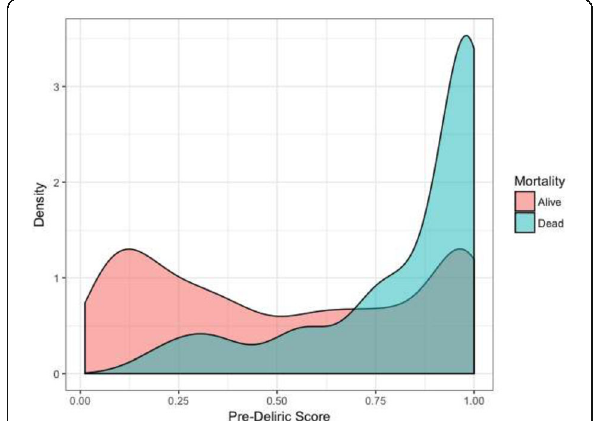
Fig. 2 (abstract 0033). Density graph of Pre-Deliric score VS Mortality. EDR was found to be increasing in the last 3 years without a clear explanation